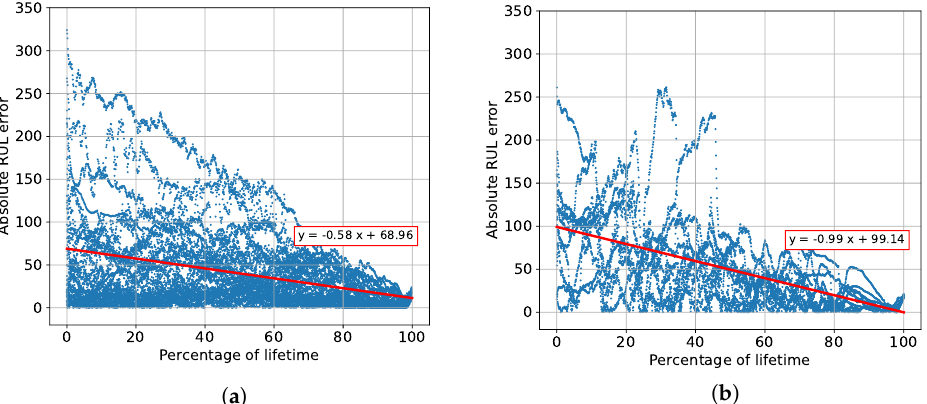
Figure 2. Error of RUL prediction compared with percentage of lifetime for test data (exponentially smoothed models). The red lines display a least squares linear regression fit through the points. ( a ) Severson–Attia dataset; ( b ) Baumhöfer